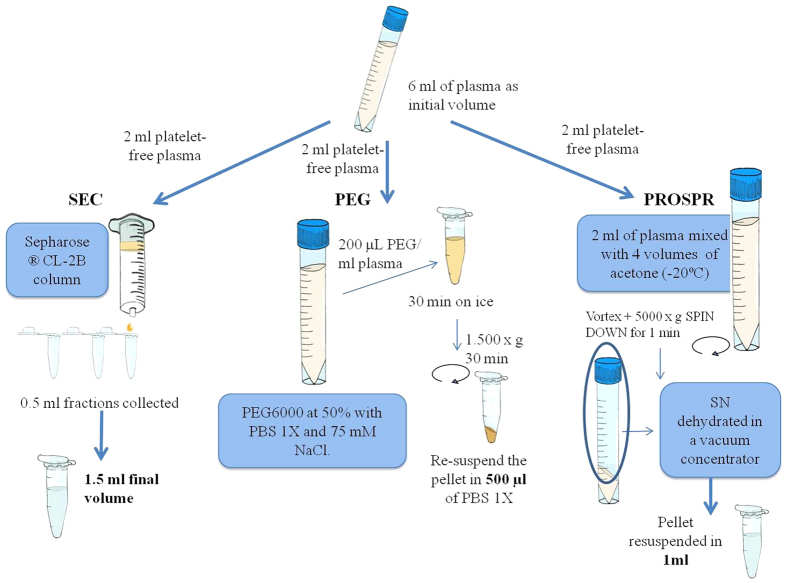
Schematic representation and description of the main steps involved in the three methodologies used for the isolation of EVs.